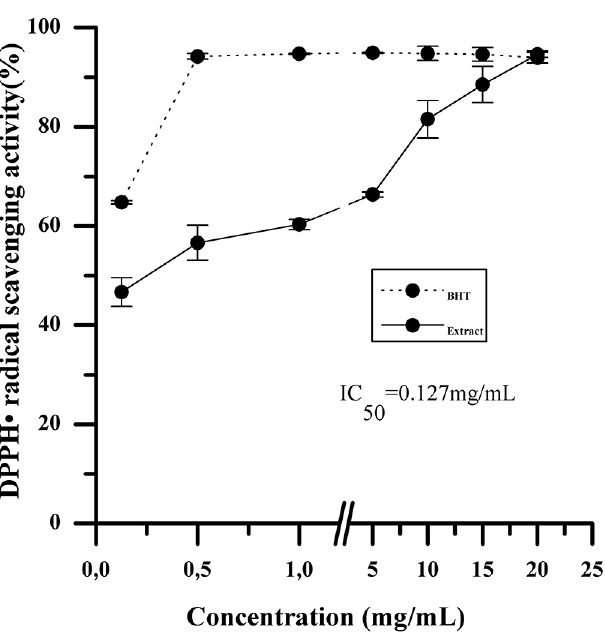
FIGURE 1 - Trapping Potential DPPH Assay of the Passiflora edulis leaf ethanolic extract compared with the standard BHT.